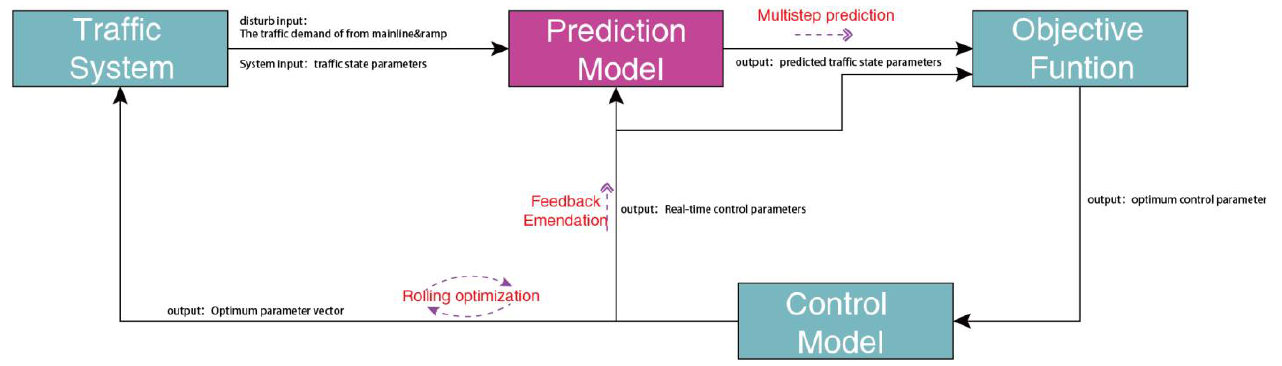
Figure 5. Structure of traffic control system based on MPC.